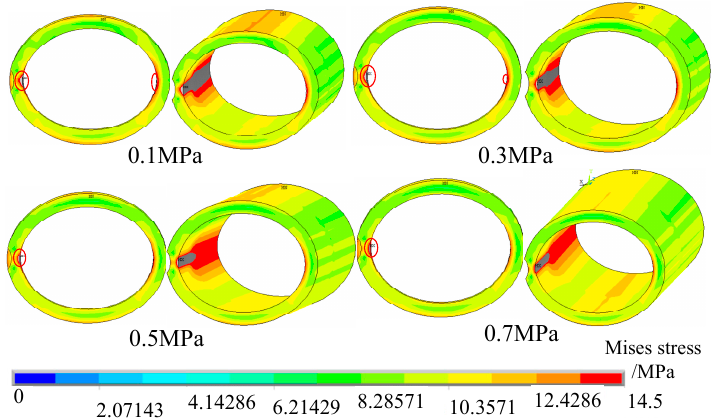
Figure 14. Location of HDPE pipeline failure with different internal pressures.